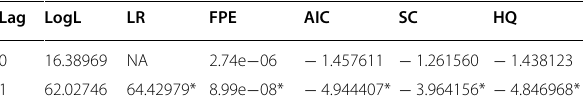
Table 4 Lag selection criterion Source : Author’s computation based on